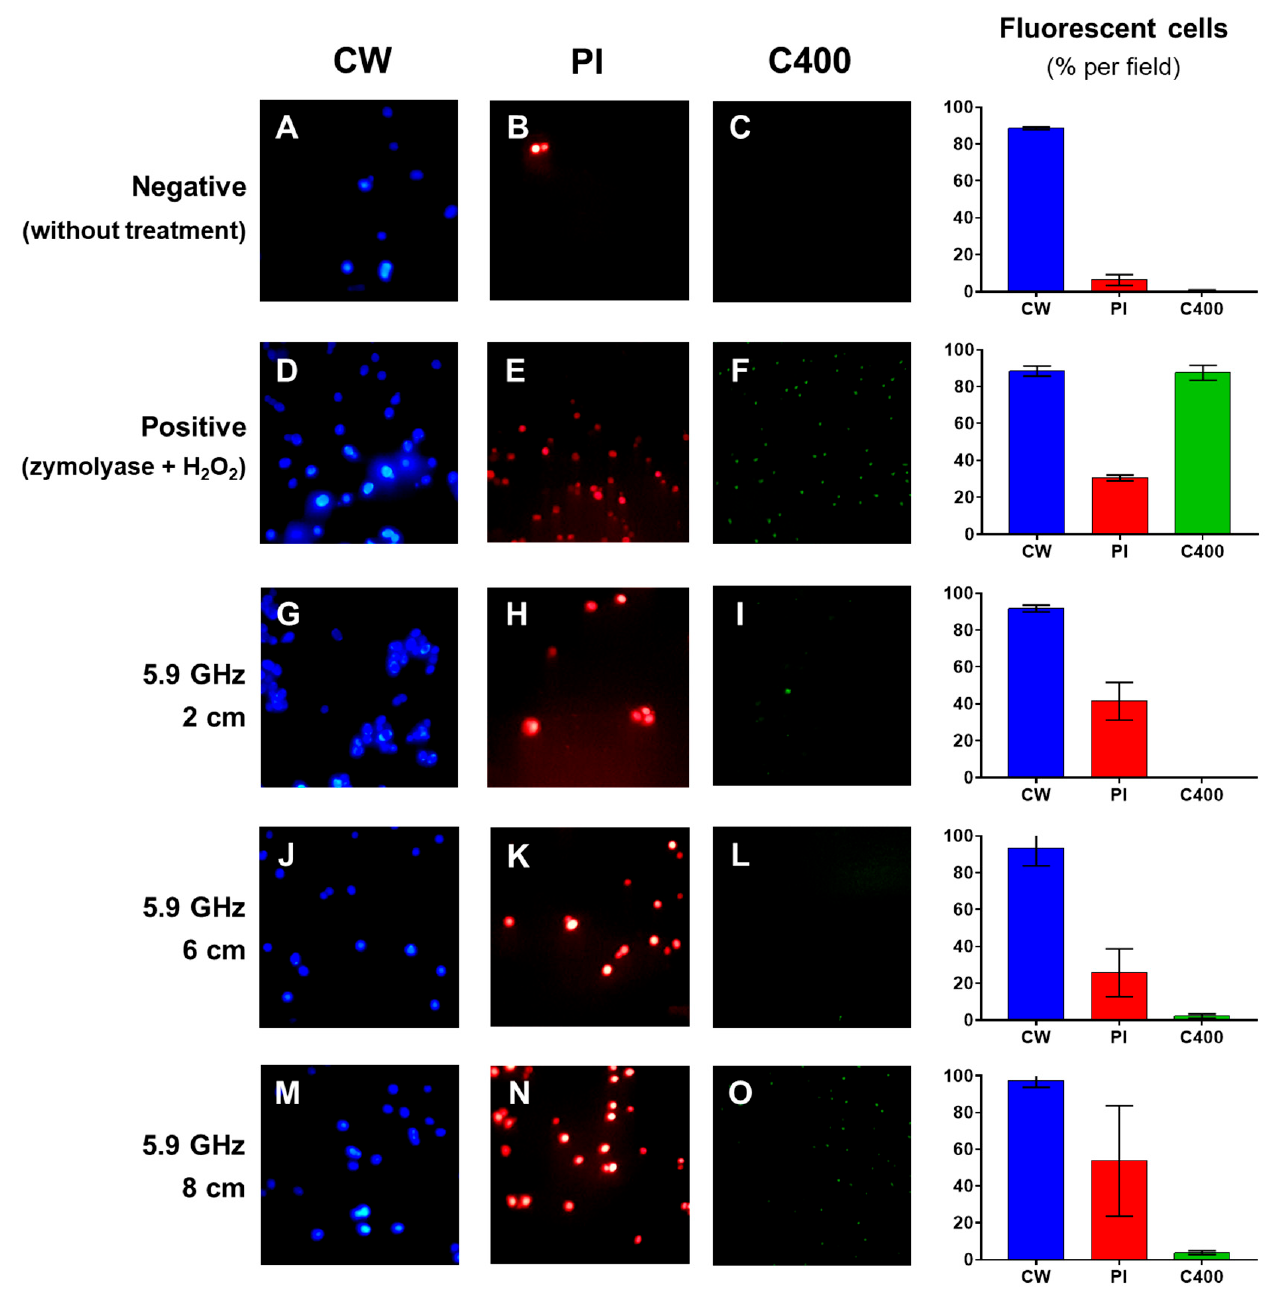
Figure 3. Fluorescence microscopy of S. cerevisiae EC1118 exposed to 5.9 GHz for 15 min at different distances from the antennas. The stains used were calcofluor white (CW; blue), propidium iodide (PI; red), and 6-carboxy-2’,7’-dichlorodihydrofluorescein diacetate (C400; green). The graphs on the right of each line represent a percentage of fluorescent cells per field counted in each treatment in duplicate. ( A – C ): untreated yeasts (negative control). ( D – F ): yeasts after treatment with zymolyase (600 µ g/mL) before exposure to H 2 O 2 30% v / v for 30 min (positive control). ( G – I ): yeasts exposed at 2 cm from the antenna. ( J – L ): yeasts exposed at 6 cm from the antenna. ( M – O ): yeasts exposed at 8 cm from the antenna.